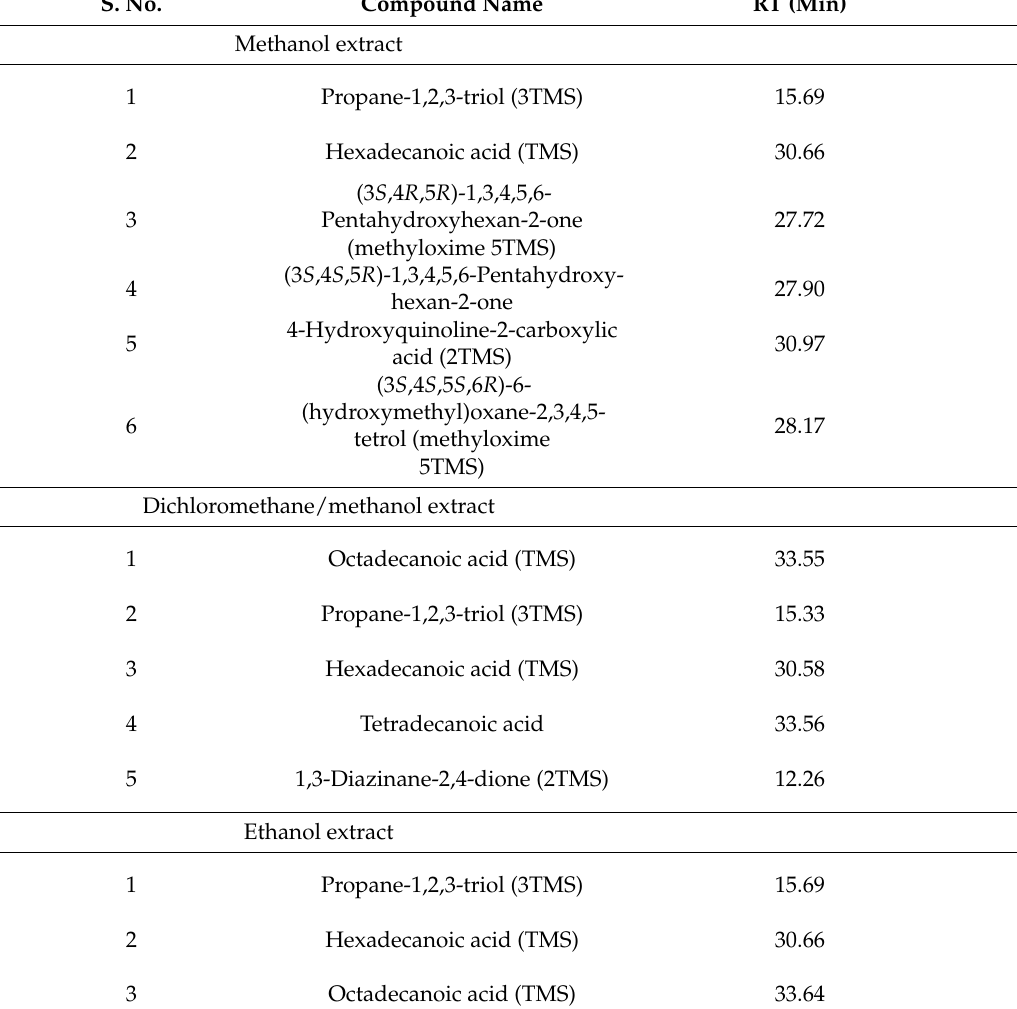
Table 2. Major derivatized constitutes of different solvent E. foeminea extracts analyzed by GC–MS. S.